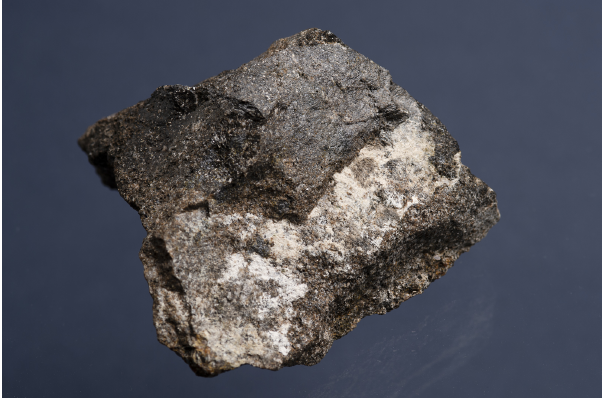
Figure 1. Type specimen, GEO-NRM #19221254, of ferri-taramite (brownish black aggregate on top) with mostly phlogopite (brown) and celsian–baryte (whitish). Field of view 60 × 100mm. Torb- jörn Lorin